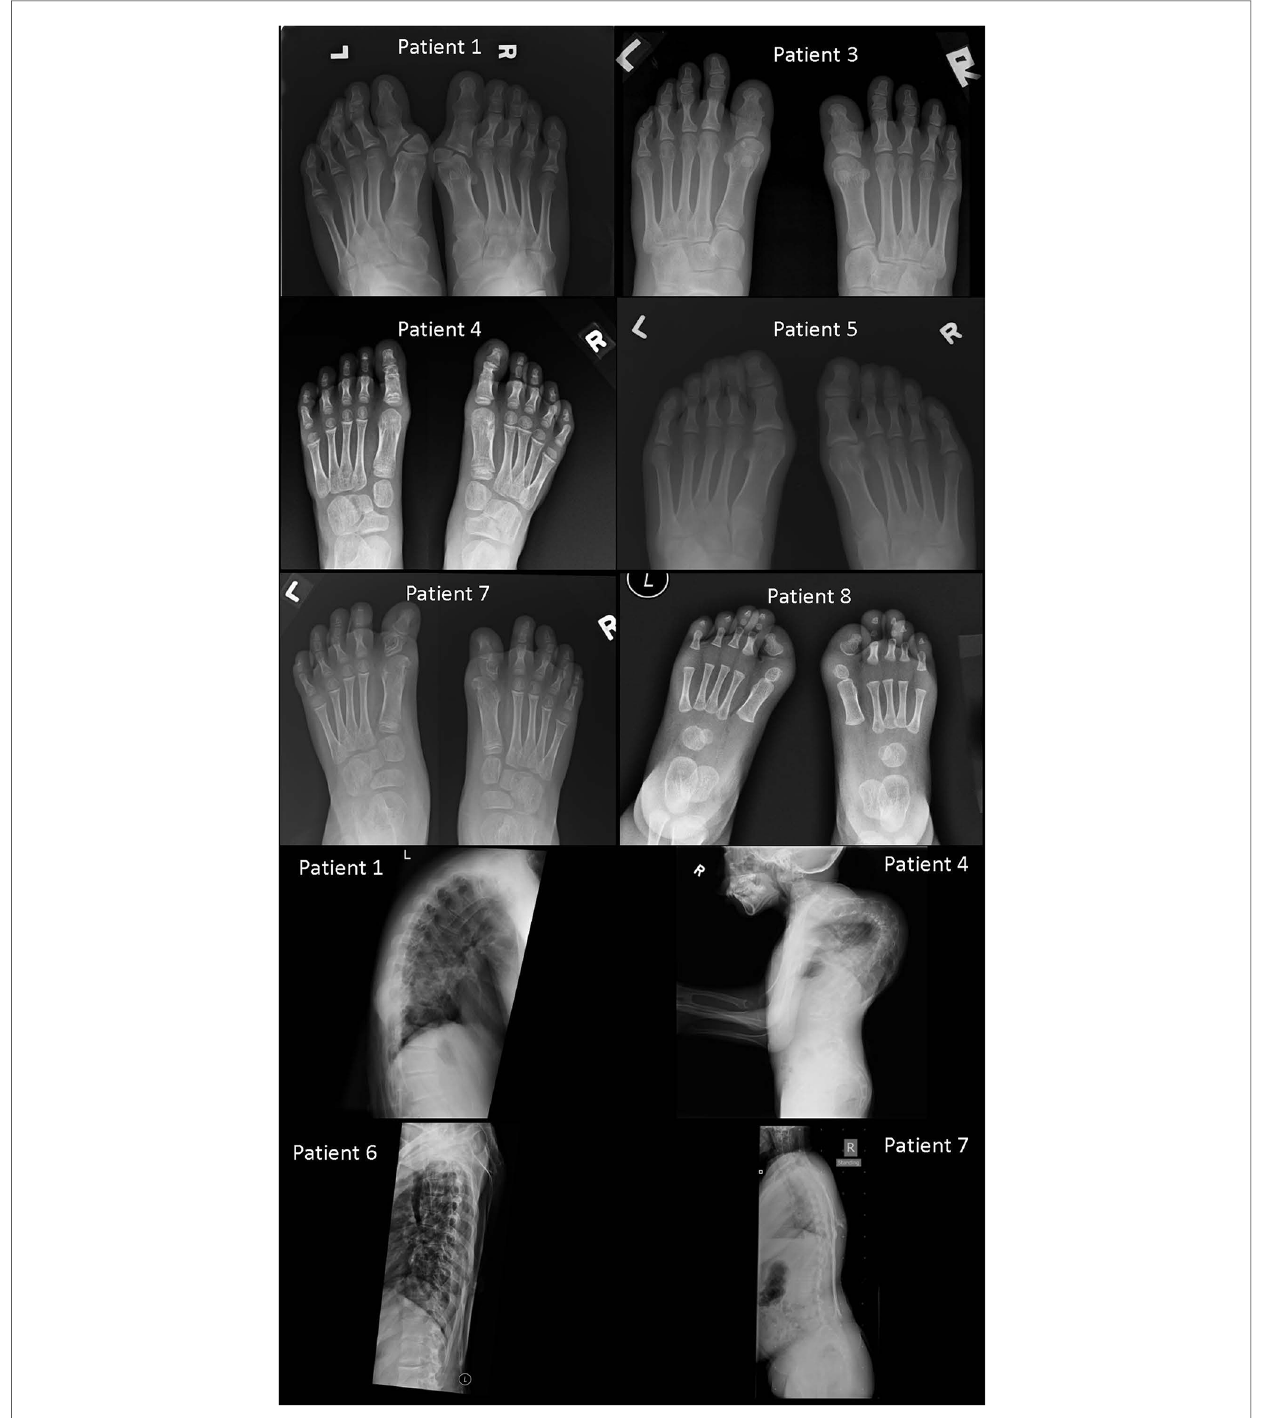
FIGURE 3 Footradiographs from Patients 1, 3, 4, 5, 7, and 8, and spine radiographs fromPatients 1, 4, 6, and 7 (foot radiographs). Patient 1: Deformed heads of bilateral fi rst metatarsalsandproximalphalangeswithhalluxvalgus.Fusedproximalanddistalphalangesofbothbigtoes.Patient3:Deformedheadsofbilateral fi rstmetatarsals andphalangesofbilateralbigtoes.Theyarehypoplasticandshortwithfusionofproximalanddistalphalangesofbothbigtoes.Patient4:Tri-phalangealbigtoeson both sides with fusion of the proximal and middle phalanges. Subtle hallux valgus. Patient 5: Subtle hallux valgus. Patient 7: Dysplastic heads of bilateral fi rst metatarsals and proximal phalanges of both big toes. Right big toe appears short. Patient 8: Bilateral heads of fi rst metatarsals appear dysplastic with short hypoplastic bilateral big toes with single phalanx. Bilateral hallux valgus (spine radiographs) Patient 1: Ossi fi cations of the paravertebral soft tissue demonstrated on the lateral view with a kyphotic spinal curvature. Patient 4: Extreme kyphoscoliosis of the whole spine with segments of cervical spine fusion and impending chin-on-chest deformity. Patient 6: Relative preservation of normal thoracic spinal alignment with no major heterotopic ossi fi cations. This spinal radiograph is taken at similar age as that of Patient 1. Patient 7: Paraspinal soft tissue ossi fi cations extending from upper back down to upper sacral level with relatively preserved vertical spinal alignment. This spinal radiograph is taken at similar ageas that of Patient